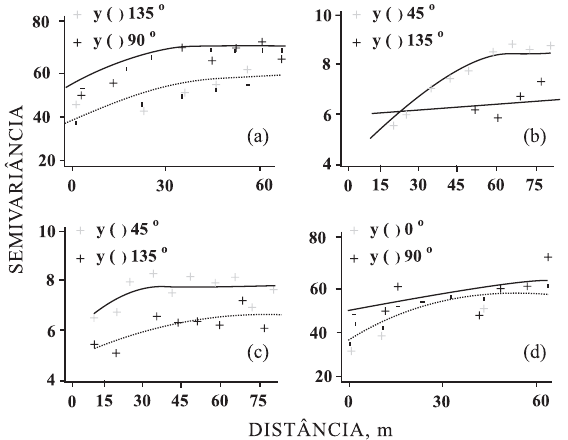
Figura 6. Modelos ajustados aos semivariogramas direcionais corrigidos das variáveis Fe (a) e resíduos de MO (b), Mn (c) e H + Al (d).